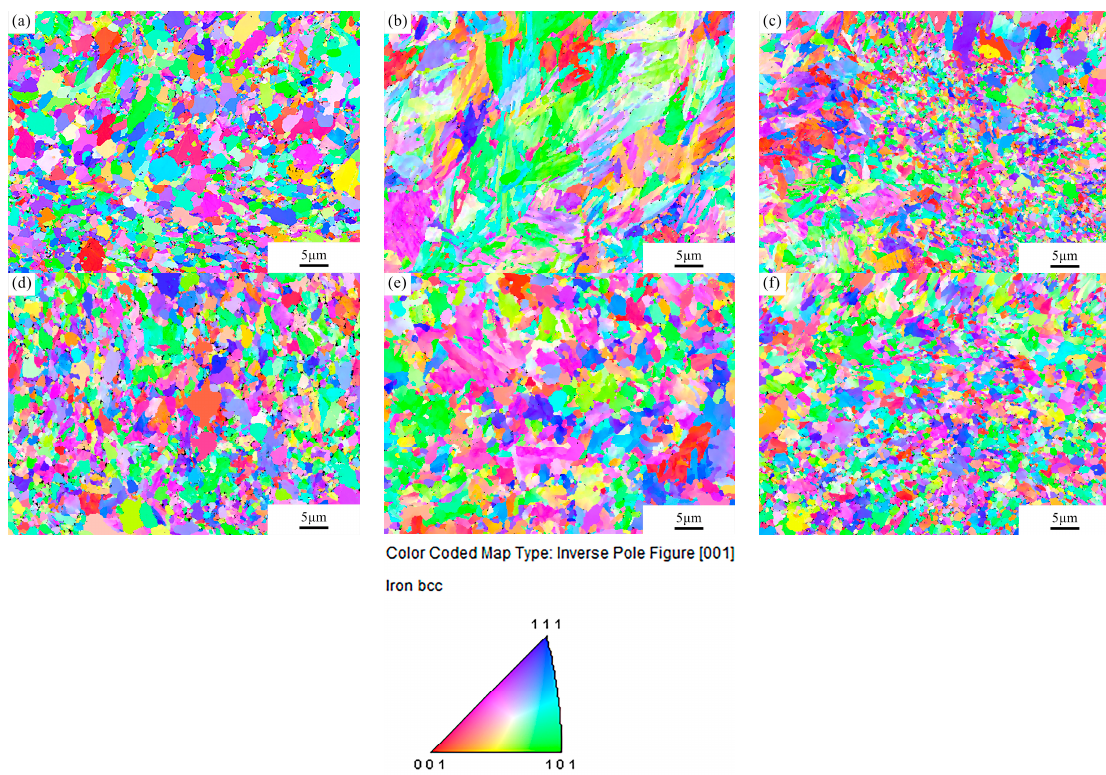
Figure 6. Inverse pole figure (IPF) maps of different regions: ( a ) base material, ( b ) fusion zone, ( c ) HAZ, ( d ) heat-treated base material, ( e ) heat-treated fusion zone and ( f ) heat-treated HAZ.